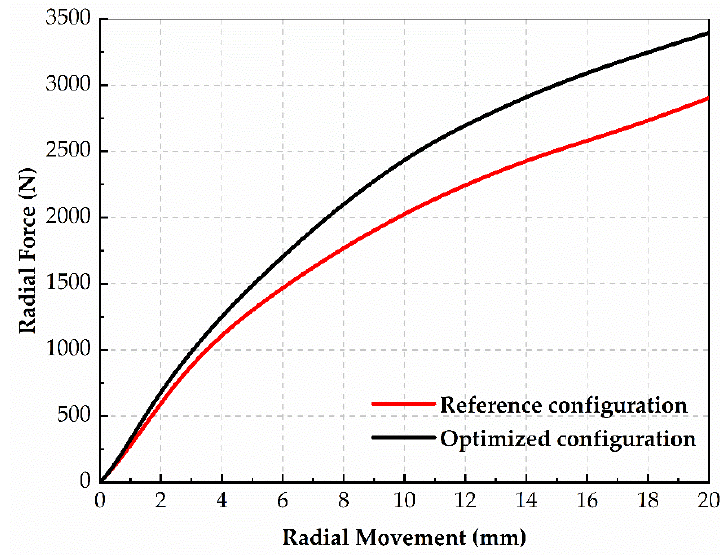
Figure 19. Vertical stiffness of the reference and optimized configurations.